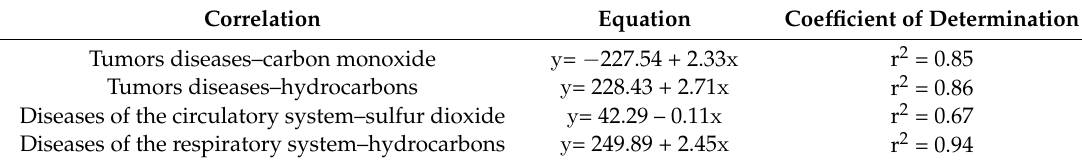
Table 3. Regression equations of disease dependence by main classes of diseases on emissions of harmful substances.